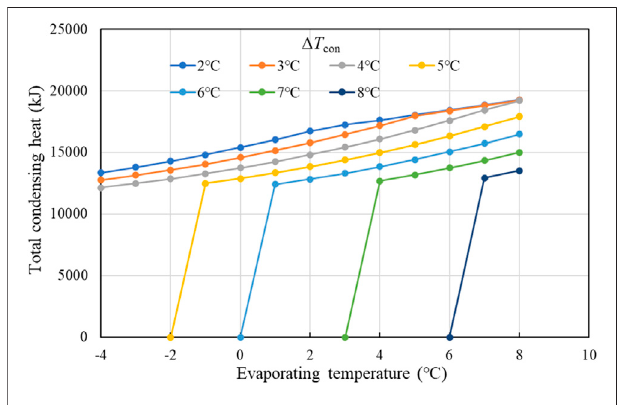
FIGURE 12 | Effects of evaporating temperature on total condensing